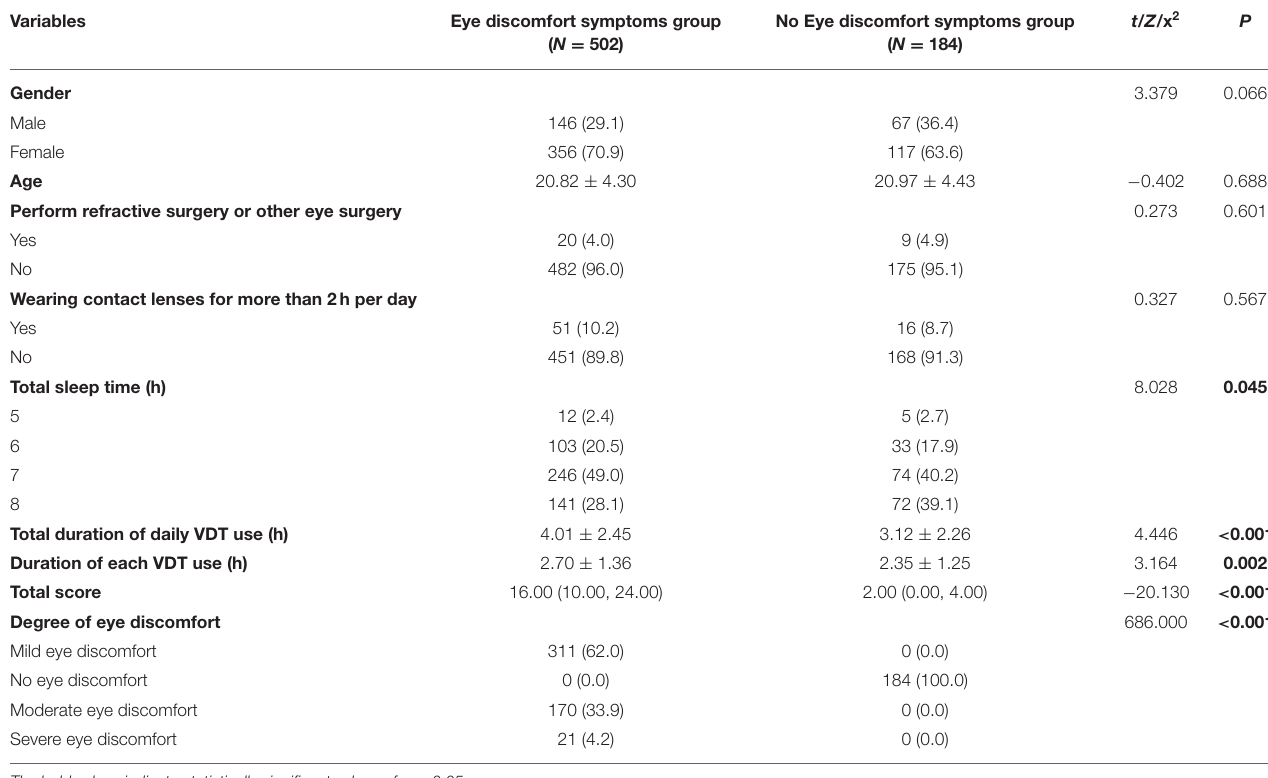
TABLE 2 | Single factor comparison eye discomfort symptoms group vs. no eye discomfort symptoms group.